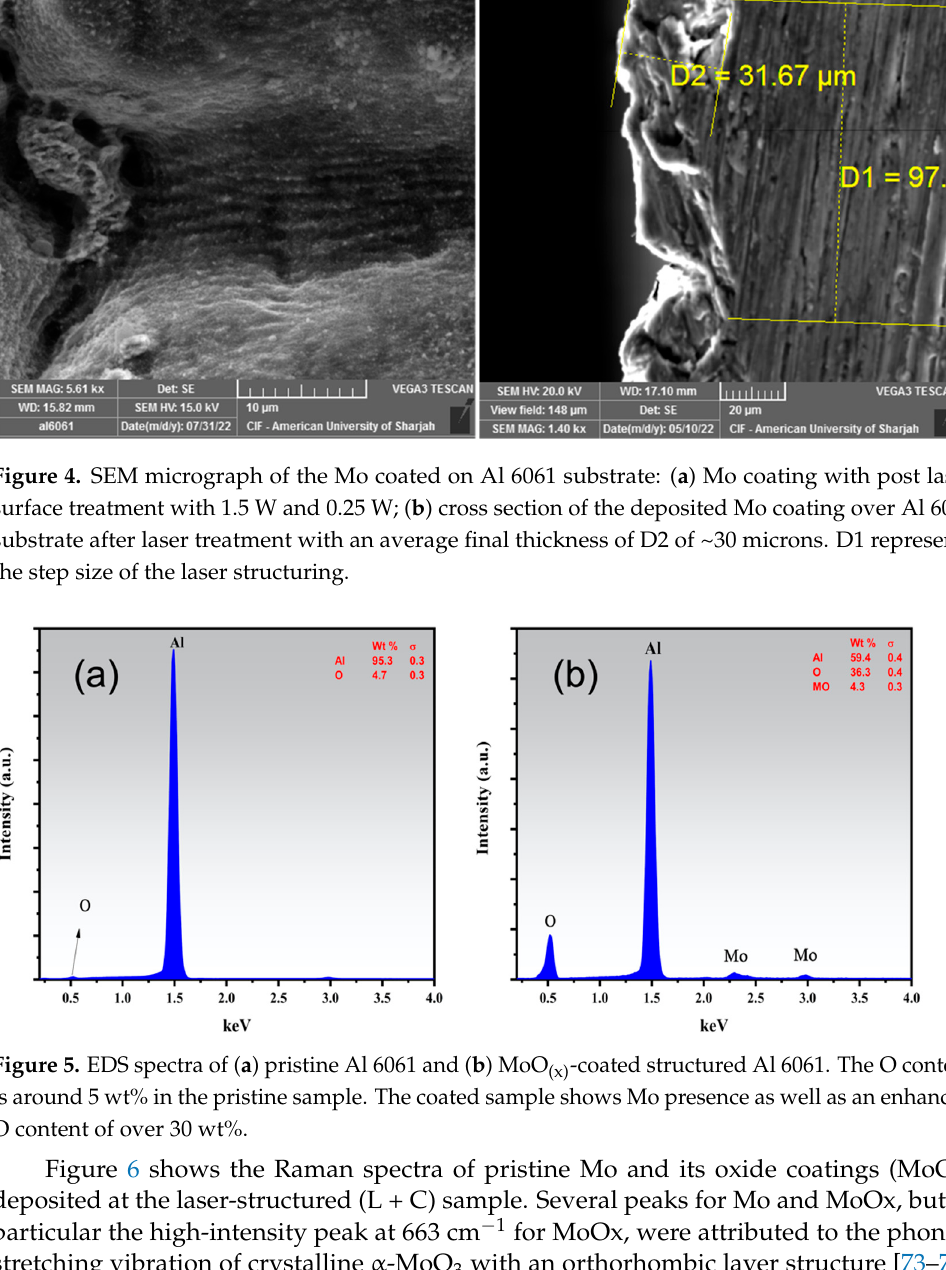
7 of 16 Figure 3. SEM images of laser-structured surfaces: ( a , b ) formation of microgroove structures on the Al 6061 surface as a result of femtosecond laser ablation. To develop Mo-based coatings on top of the crosshatched microgroove-structured Al 6061, we employed an all fs-PLD process. We recently developed this technique for pro- ducing high quality refractory metal oxide coatings [30]. The technique involves a raw deposition step followed by subsequent high-speed scanning in ambient atmosphere to produce refractory metal oxides. In this study, we employed this technique to develop an Mo oxide coating on top of the laser-structured Al 6061.